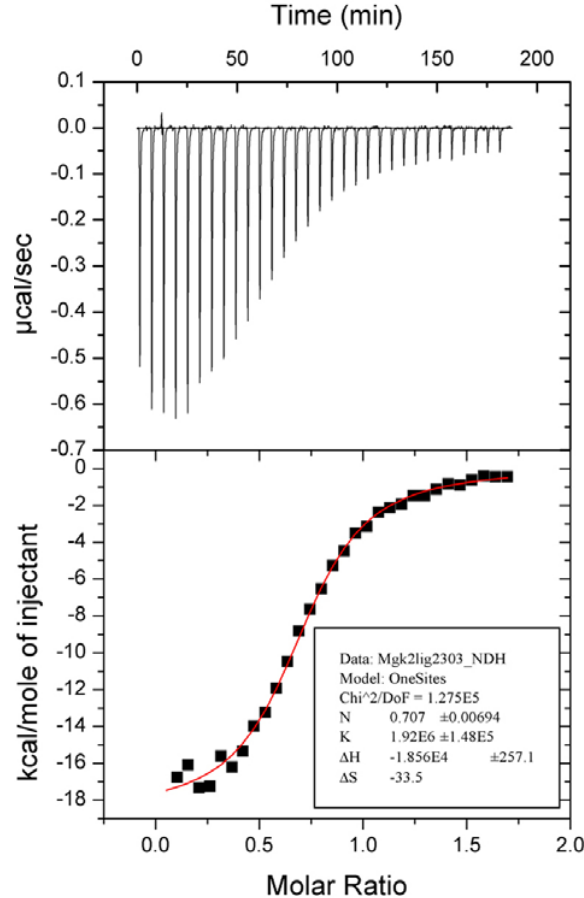
Figure 4 . A typical ITC experiment using VP-ITC (MicroCal). Ino- sitol hexakisphosphate kinase 2 was titrated with inositol hexakisp- hoshate.